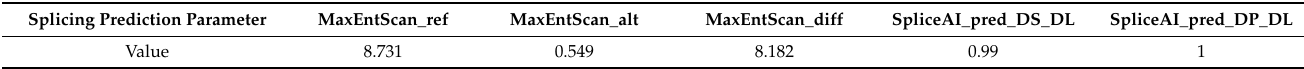
Figure 3. Electropherograms confirmed NM_000257.4:c.895+1G>A in the genome of patients III-4 and II-5 and a wildtype sequence in III-5 and II-6. Table 2. Values of the bioinformatic splicing predictors used for the analysis of the variant of interest (NM_000257.4:c.895+1G>A). According to MaxEntScan, the alternative allele splice site is 15.9 times weaker than the reference allele splice site (8.731 versus 0.549, value of the MaxEntScan_diff param- eter is 8.182). SpliceAI predicts the loss of the donor splice site in the next position downstream the variant with a probability of 99%.